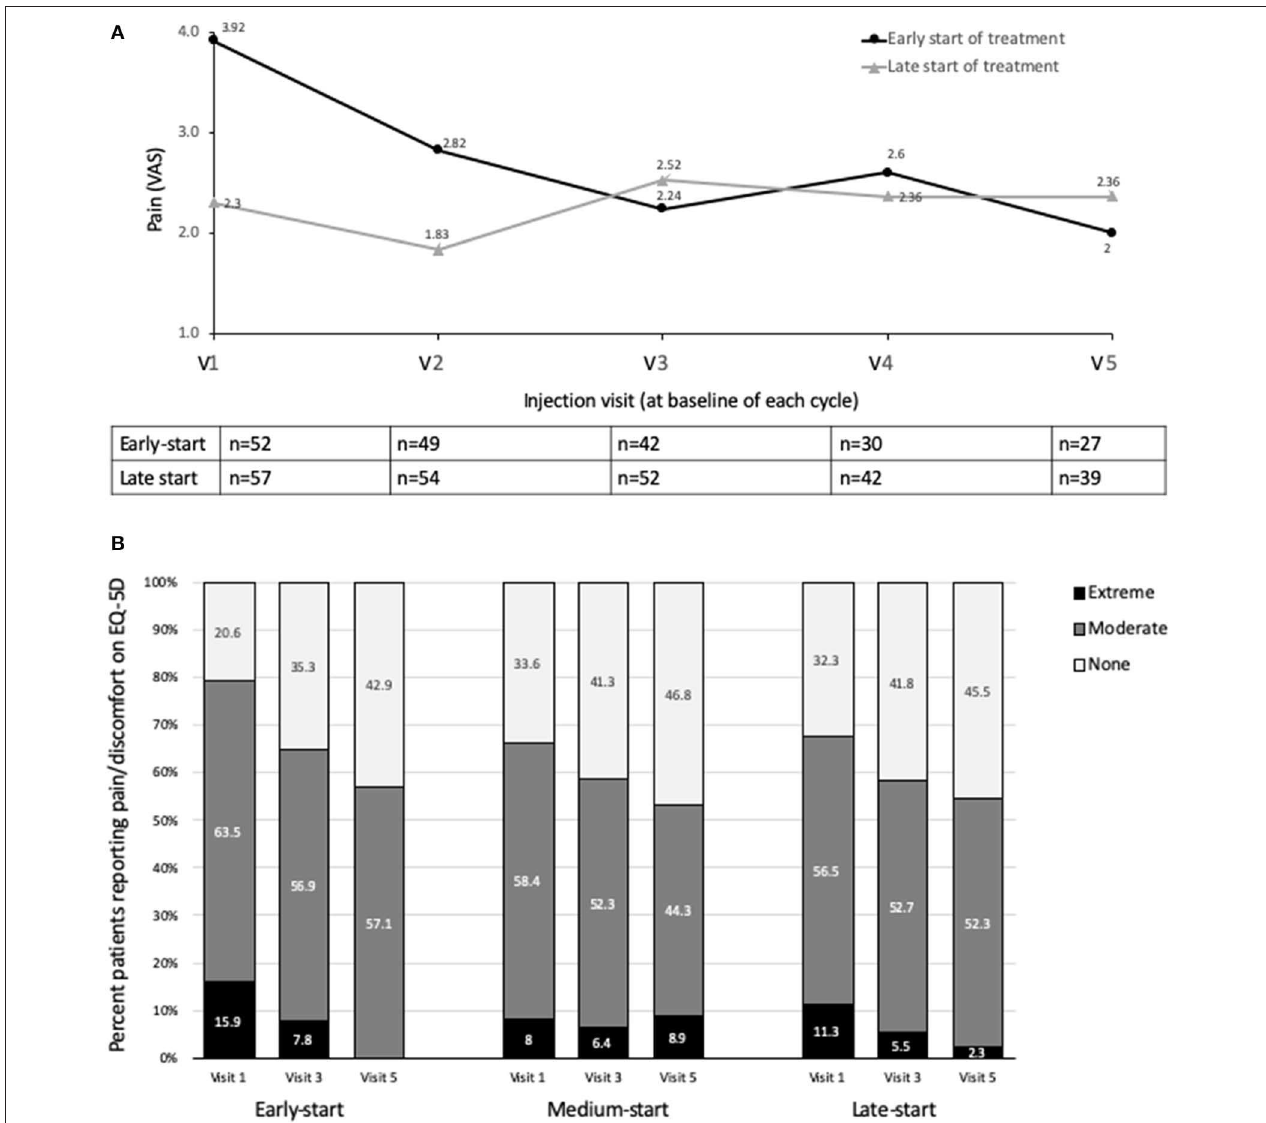
FIGURE 3 | Effects on pain (A) Descriptive statistics for pain score (VAS), early-start vs. delayed start subgroups (B) Patient quality of life (EQ-5D pain/discomfort domain). Study visits were at end of treatment cycle. VAS, visual analog